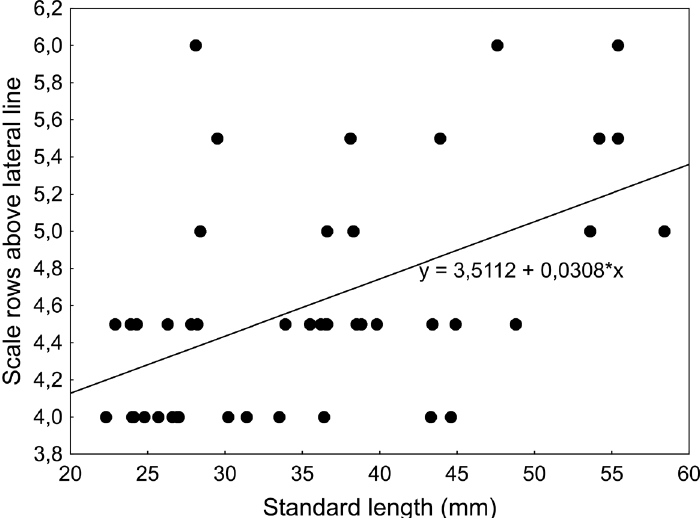
FIGURE 9 | Knodus aff. breviceps , regression analysis of the number of scale series between dorsal-fin origin and lateral line. R 2 = 0.26; p =